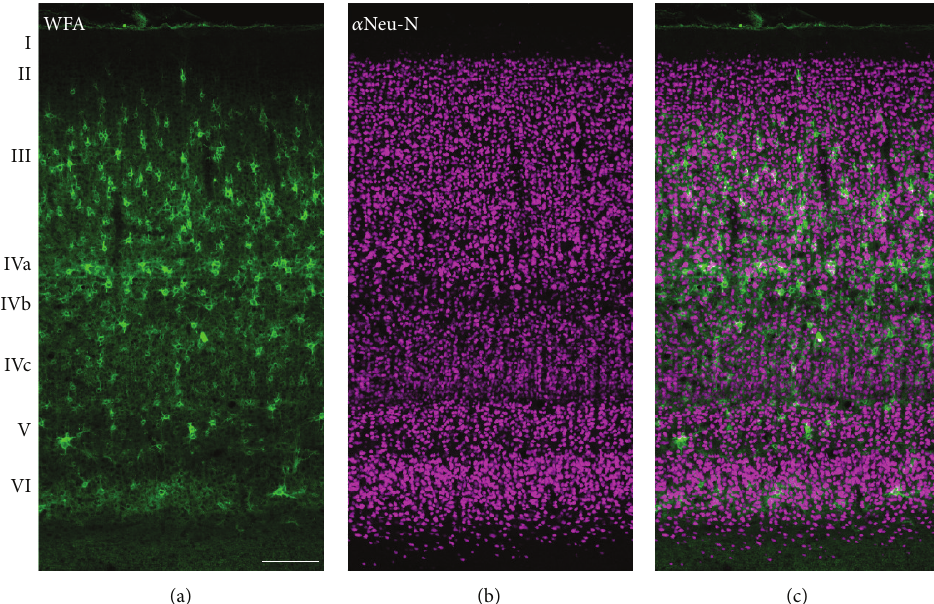
Figure 5: Perineuronal nets in primary visual cortex layers. (a) shows perineuronal nets stained with WFA. (b) shows NeuN-labeled neurons. (c) shows merged images of the two. Scale bar = 200 𝜇 m.